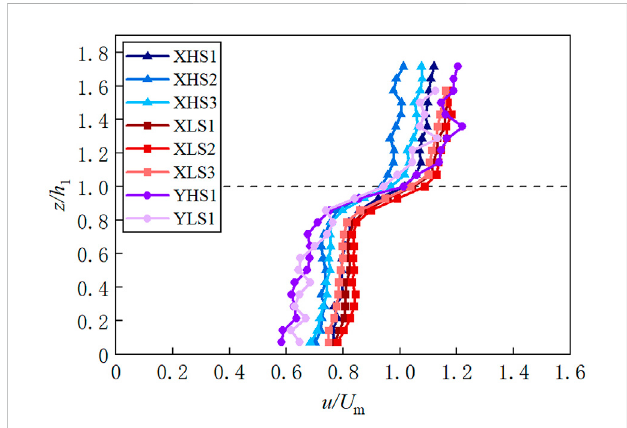
FIGURE 5 Vertical pro fi le of the dimensionless mean longitudinal velocity for each run. The black dotted line represents the height of the short